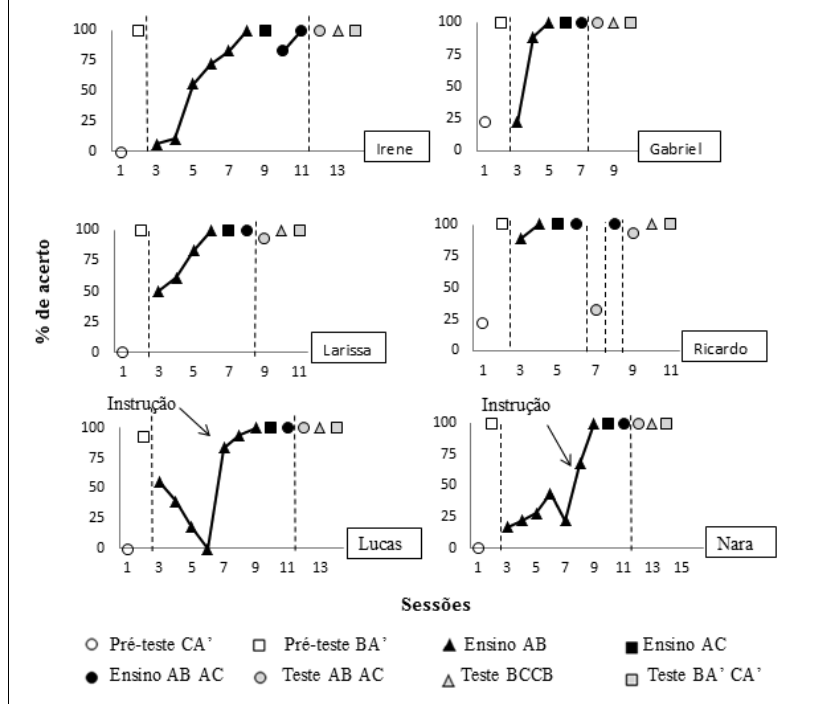
Figura 3 . Desempenho dos participantes nos pré-testes das relações BA’ CA’, no ensino e